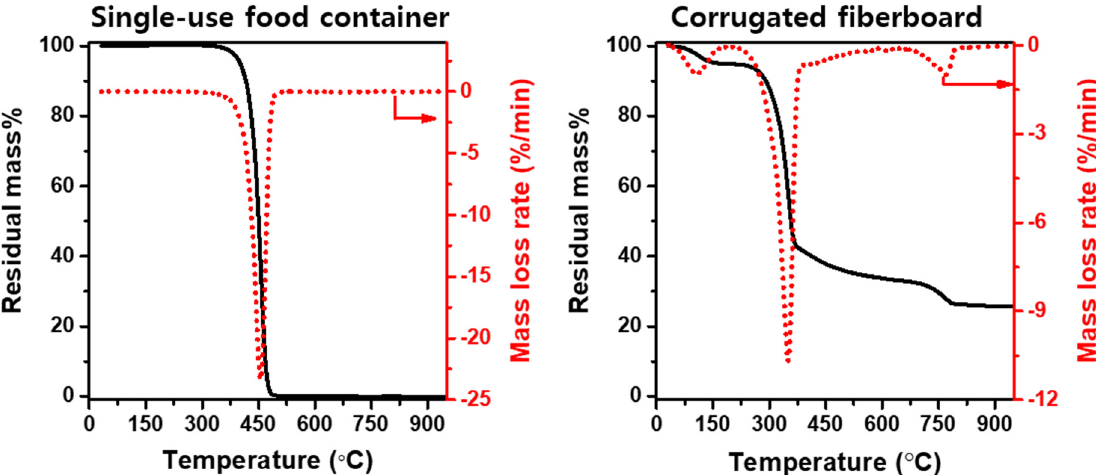
Figure 1. Residual mass% and mass loss rate of the single-use food containers and those of the corrugated fiberboard.